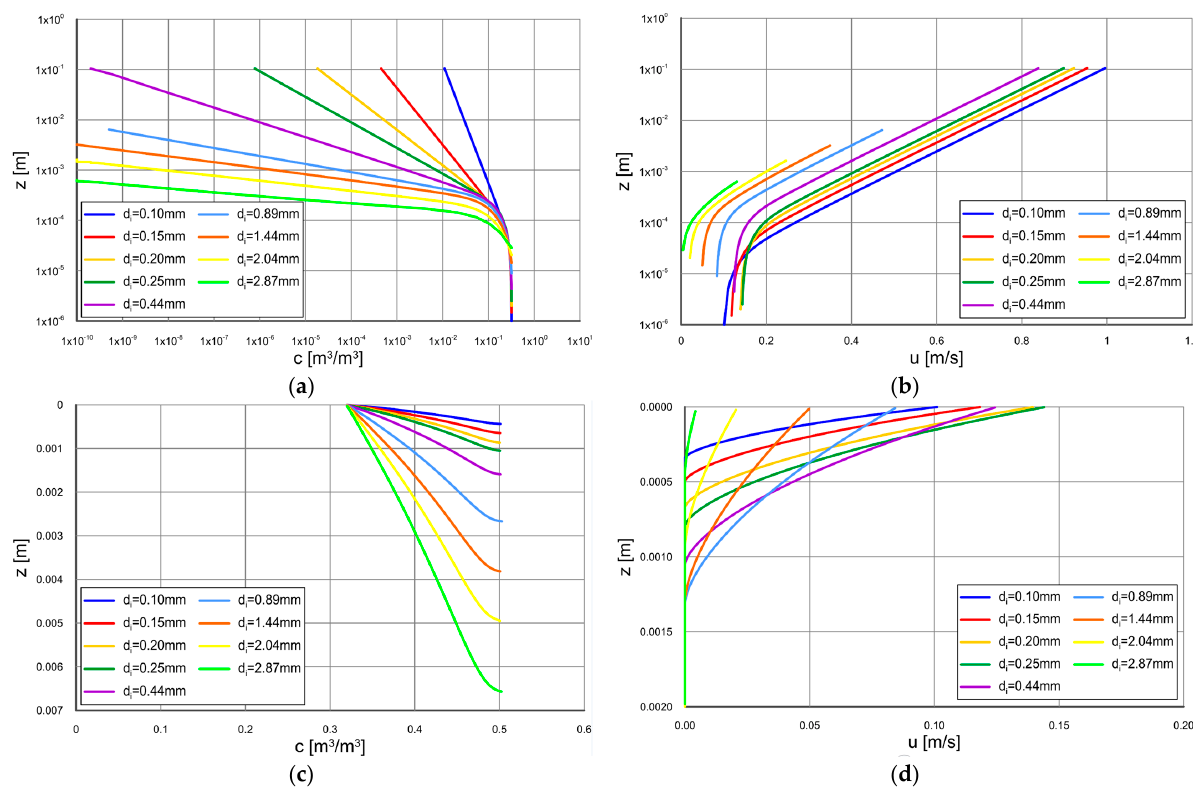
Figure 9. Calculated concentrations: ( a ) in the contact layer, ( b ) in grain collision sublayer and calculated velocities: ( c ) in the contact layer; ( d ) in grain collision sublayer for homogeneous sediments (𝑑 (cid:3045) = 𝑑 (cid:3036) ) and 𝑢′ (cid:3033)∗ = 0.042 m/s .